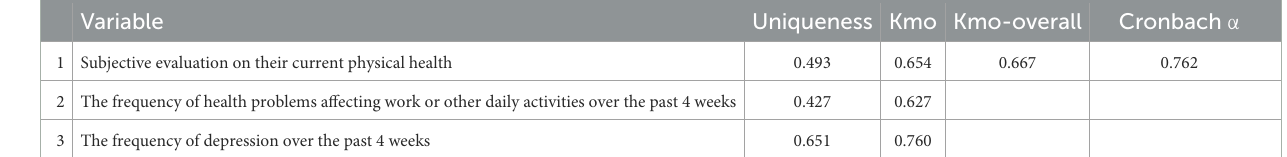
TABLE 1 Factor analysis of items of